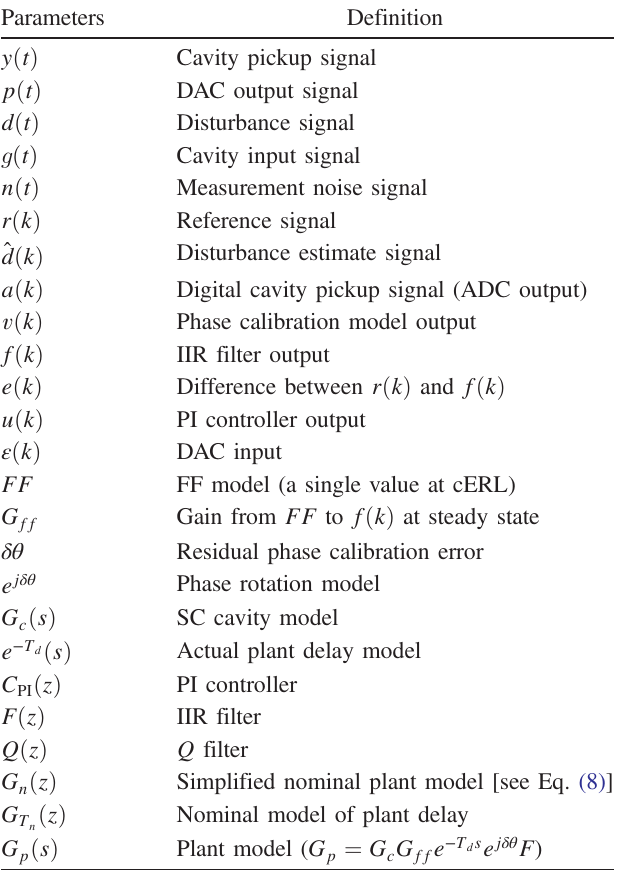
TABLE II. Definition of the parameters and models in Fig.